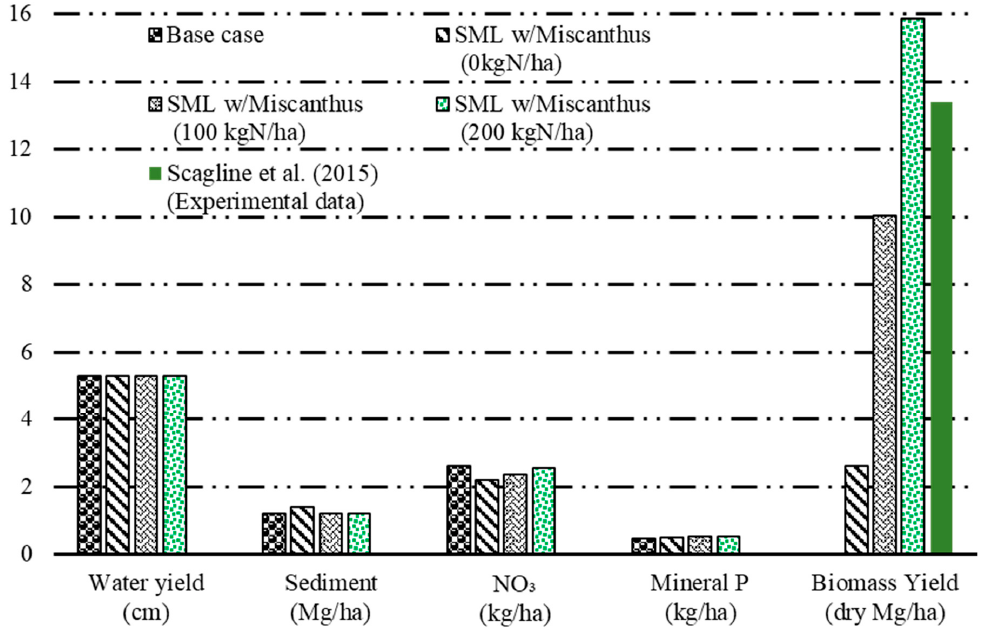
Figure 7. Simulated annual average water yield, nutrients load and biomass yield at the basin level considering the different level of fertilizer application.